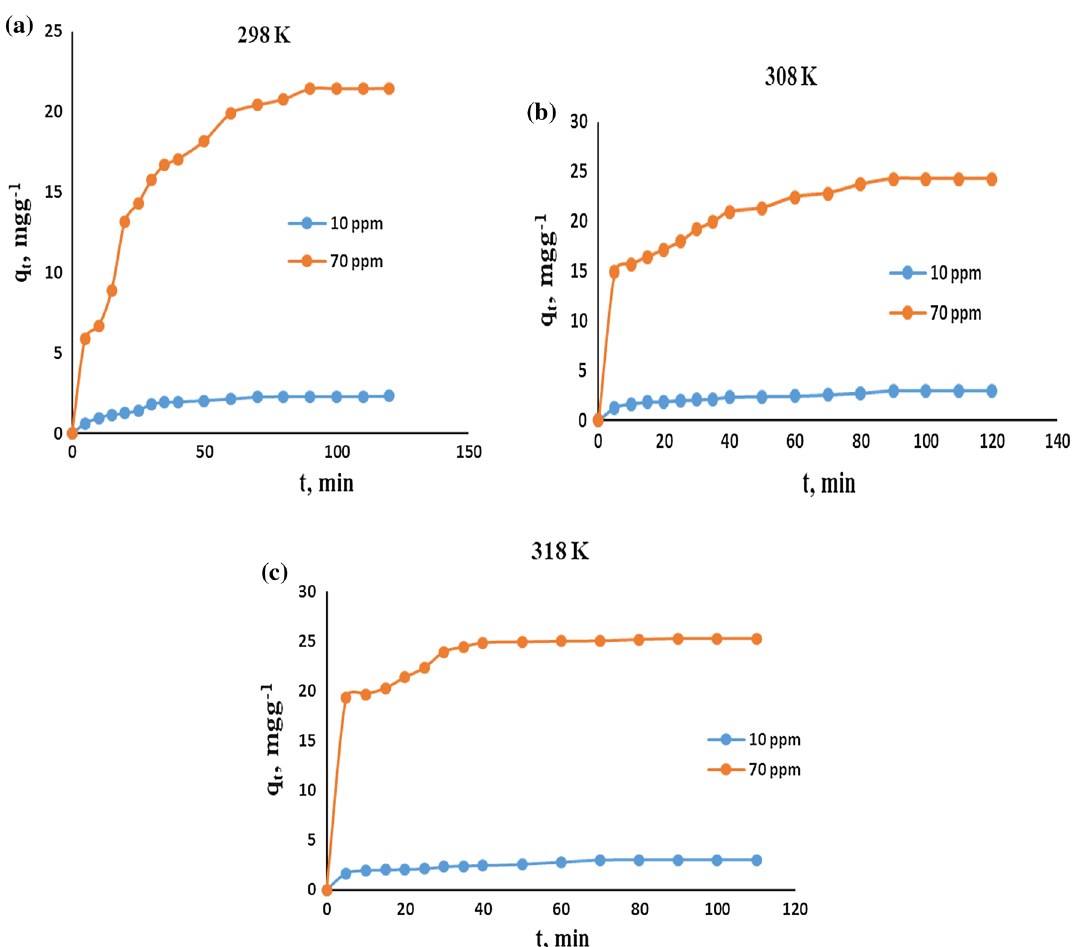
Fig. 6 The effect of contact time on the biosorption at various initial concentrations and temperatures ( a 298 K, b 308 K, c 318